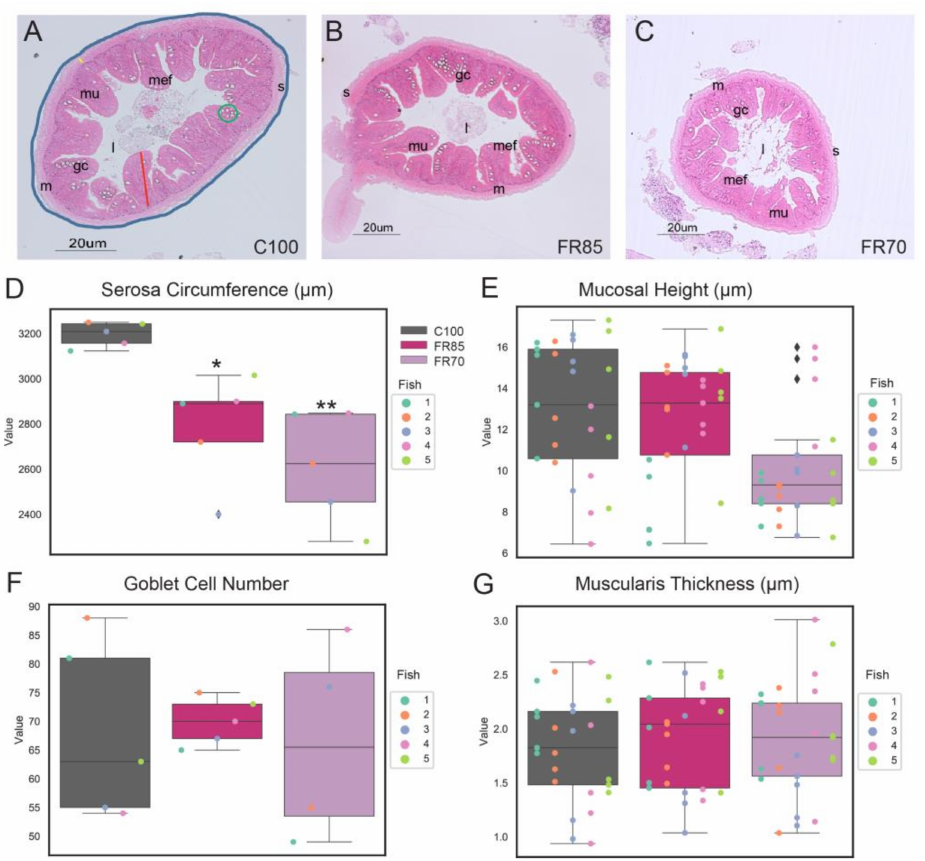
Figure 3. Histological analyses of feed restricted zebrafish reveal differences in some morphological characteristics. Representative transverse sections of Haematoxylin and Eosin (H&E)-stained mid- intestine from fish fed on ( A ) 100%, ( B ) 85%, and ( C ) 70% feed for a period of three weeks. The serosa circumference, mucosal height, muscularis thickness and goblet cell number are indicated by the blue line, red line, yellow line, and green circle, respectively. Scale bar = 20 µ m. Abbreviations: serosa (s), lumen (l), mucosa (mu), muscularis (m), goblet cells (gc), and mucosal epithelial fold (mef). ( D ) External circumferences of serosa, ( E ) mucosal height, ( F ) goblet cell number, and ( G ) muscularis layer thickness were measured from sections of the midgut. The box plot shows median, interquartile interval, and data range excluding outliers; colored dots represent data from each individual fish. (cid:7) represents an outlier. In ( E , G ), multiple data points were sampled per fish. One-way ANOVA was performed between the mean of each group with the mean of the control group, followed by the Tukey Post-hoc test, adjusting for multiple comparisons. Means that are significantly different from C100 are noted with—* Padj < 0.05, ** Padj <